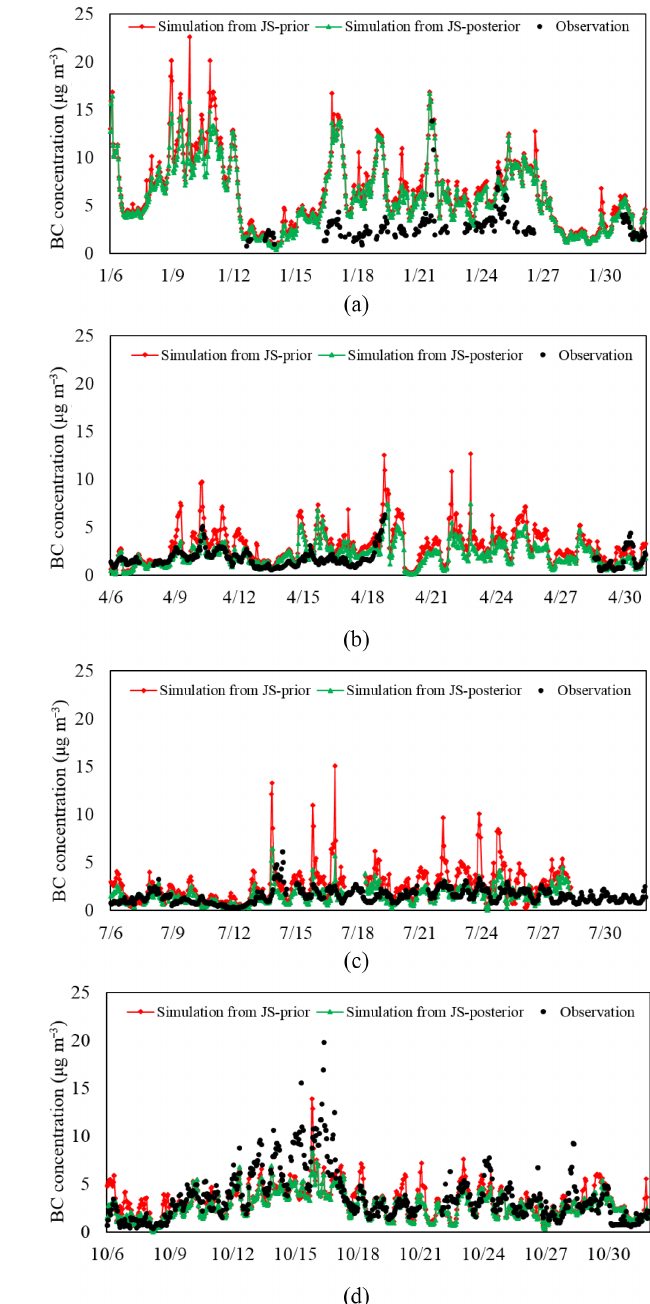
Figure 4. The same as Fig. 3 but at PAES (unit: µgm − 3